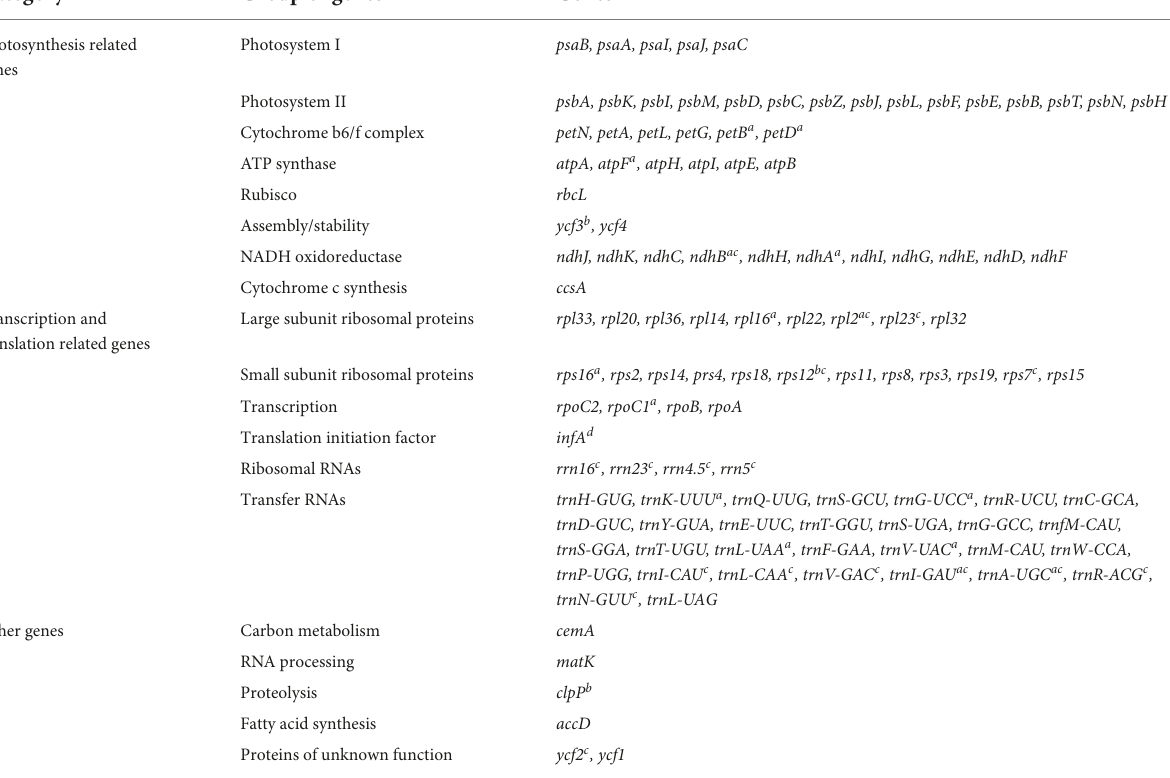
TABLE 1 Gene composition of Ficus chloroplast